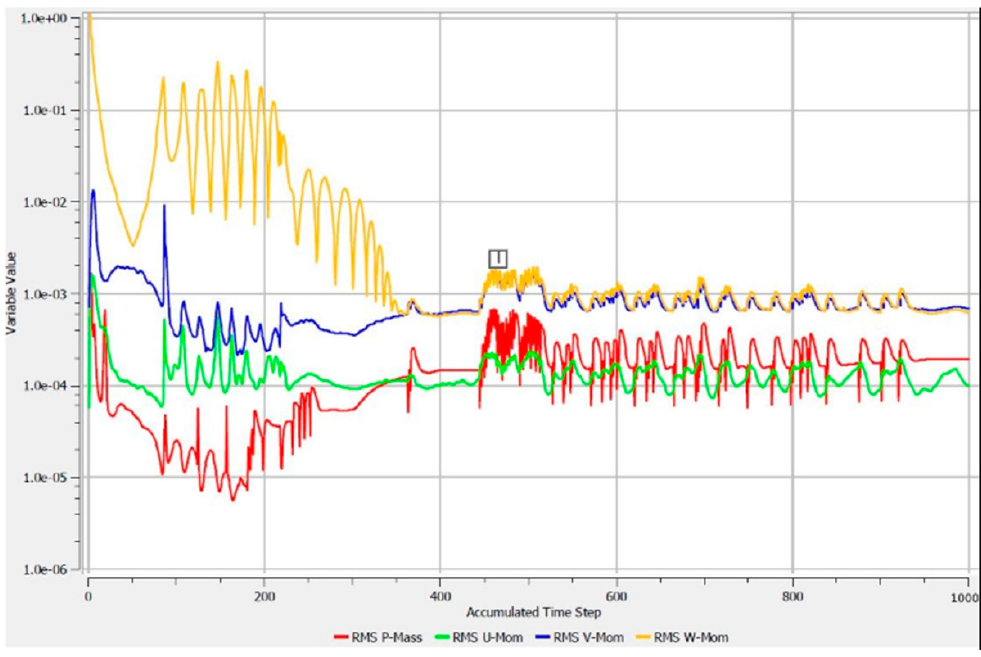
Figure 6. Residuals convergence.